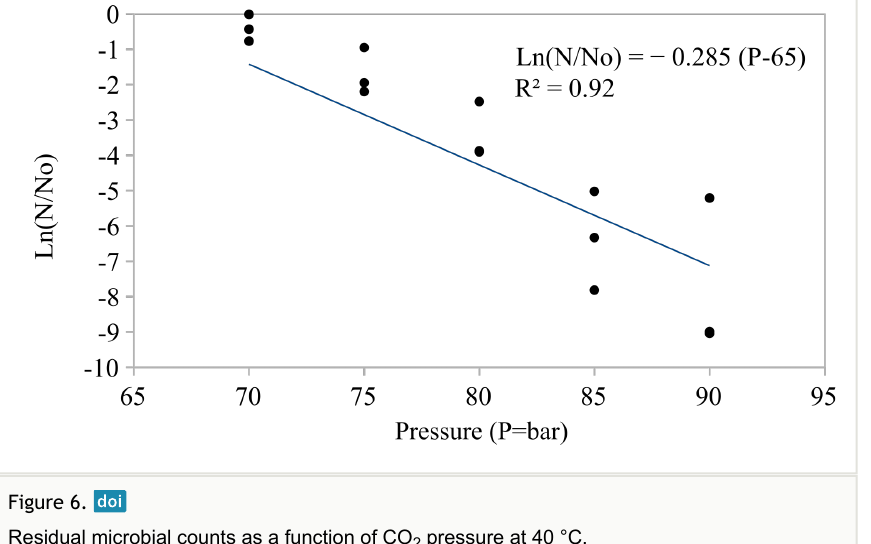
Residual microbial counts as a function of CO pressure at 40 °C.